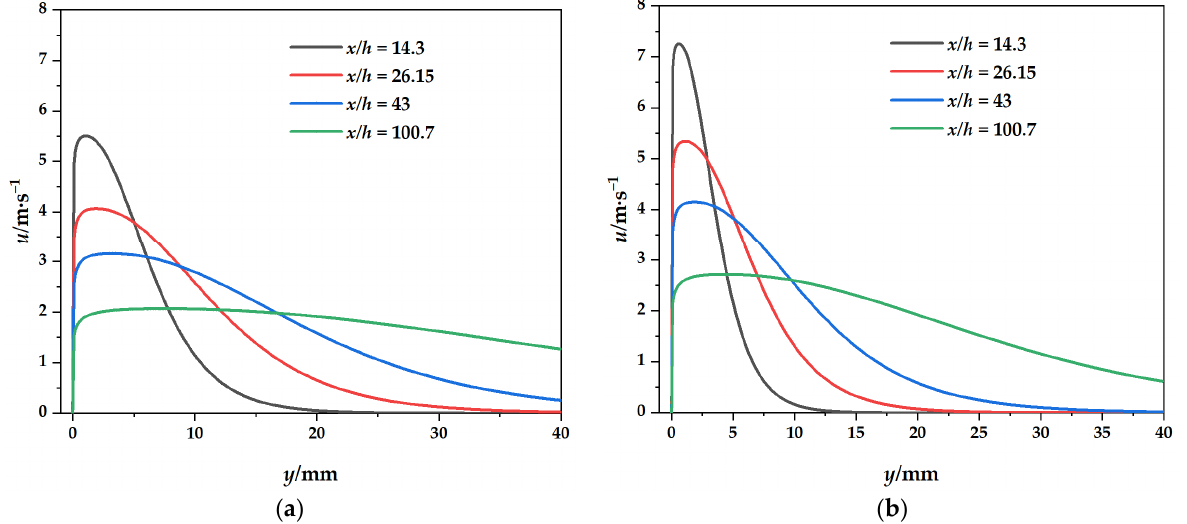
Figure 8. Velocity distribution with different x/h over logarithmic spiral wall surfaces at ( a ) x / R = 1 and ( b ) x / R = 2/3.